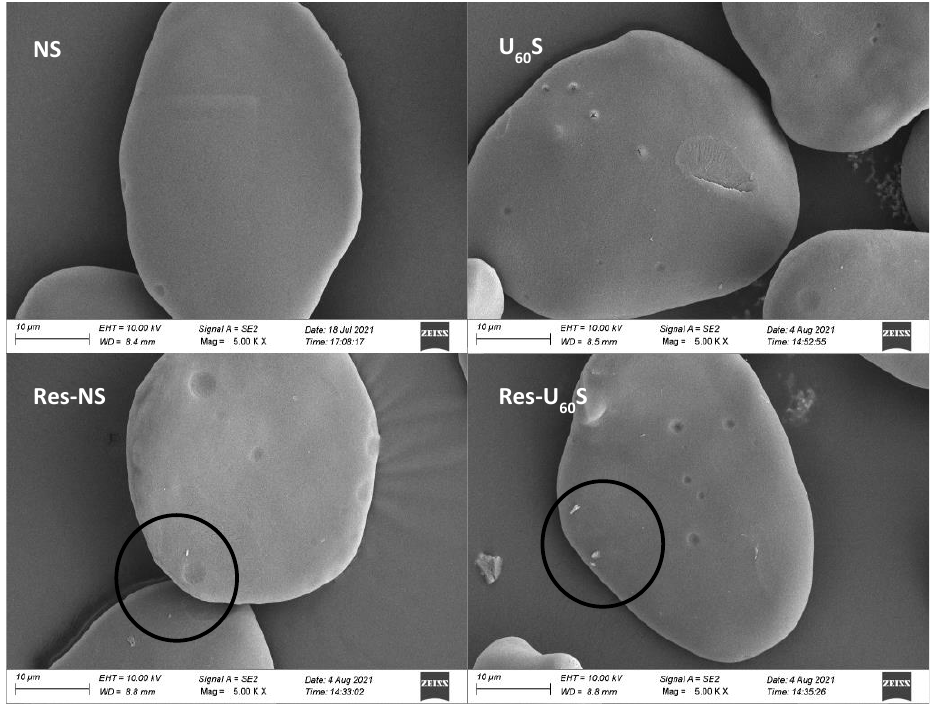
Figure 7. Scanning electron micrographs of samples.